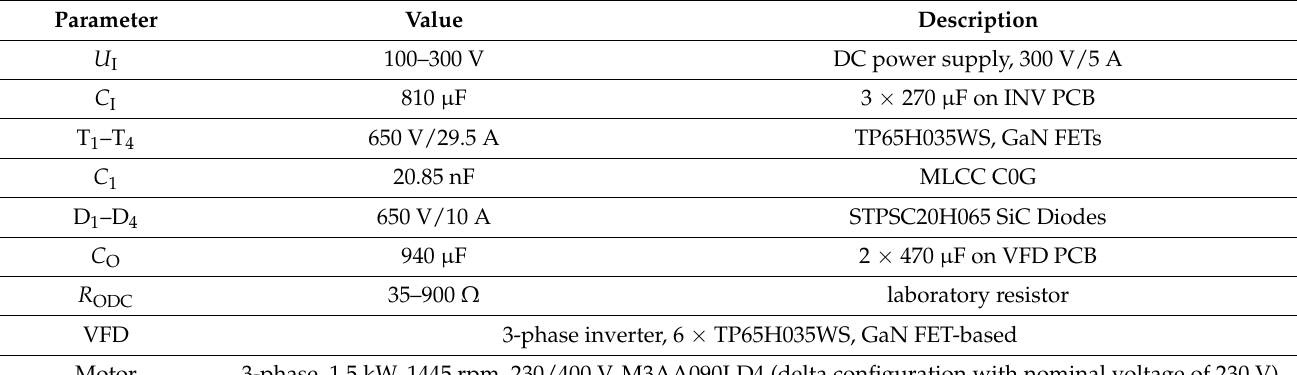
Figure 7. Photographs of IPT-IMD system prototype: ( a ) primary-side, ( b ) secondary-side. Table 2. Parameters of IPT-IMD